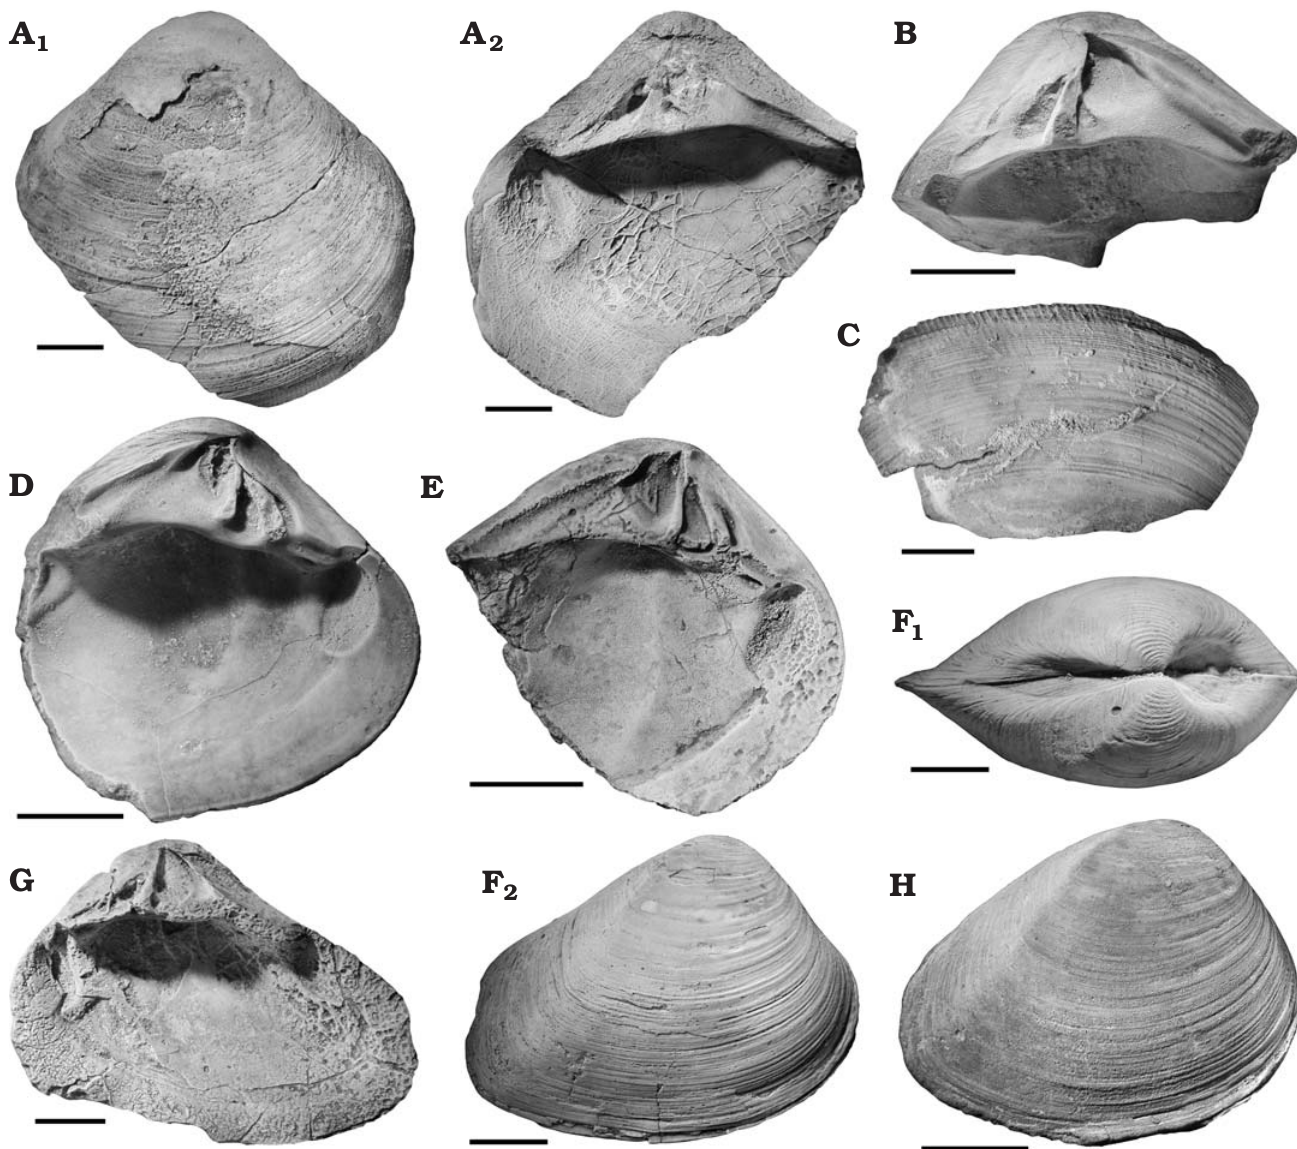
Fig. 7. Crassatellid bivalve Crassatella rafaeli sp. nov. from the late Eocene, Otuma depositional sequence, south-central Peru. A . UWBM 101834, exterior (A 1 ), and interior (A 2 ) of right valve. B . UWBM 101838, right hinge plate. C . MUSM INV 210, fragment of anterioventral margin showing striations terminat- ing in marginal crenulations. D . UWBM 101840, interior of left valve with resilifer extending half way to the vmHP. E . MUSM INV 213, interior of left valve with resilifer reaching nearly to the vmHP. F UWBM 101836, dorsal margin of paired valves (F 1 ), anterior to right, exterior of right valve (F 2 ). G . UWBM 101835, interior of right valve. H . UWBM 101837, exterior of right valve. Abbreviation: vmHP, ventral margin of the hinge plate. Scale bars 10